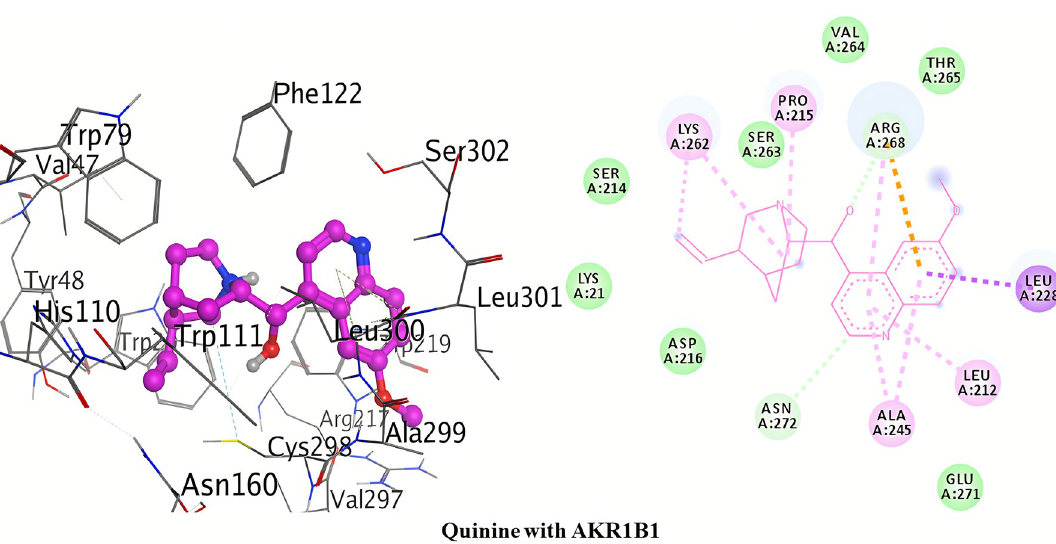
The amino acid residues of active site which were involved in hydrogen bonding with quinine included; Lys22, Ser211 and Cys299. This hydrogen bonding is of chief importance in protein- ligand interaction. Analyzing the binding interactions showed three hydrogen bonds. One